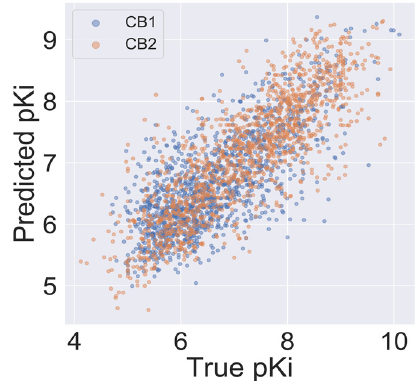
Figure 4. Autocorrelation of experimental and predicted pKi values for the CB1 model (blue) and the CB2 model (orange).